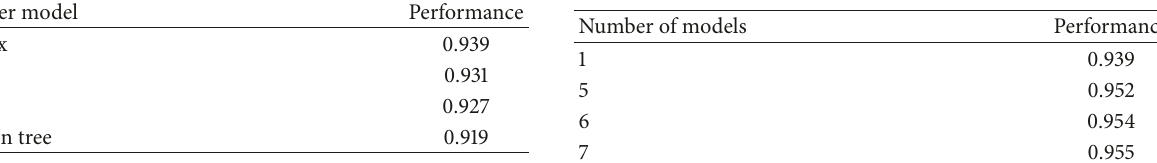
Table 8: Performance of model